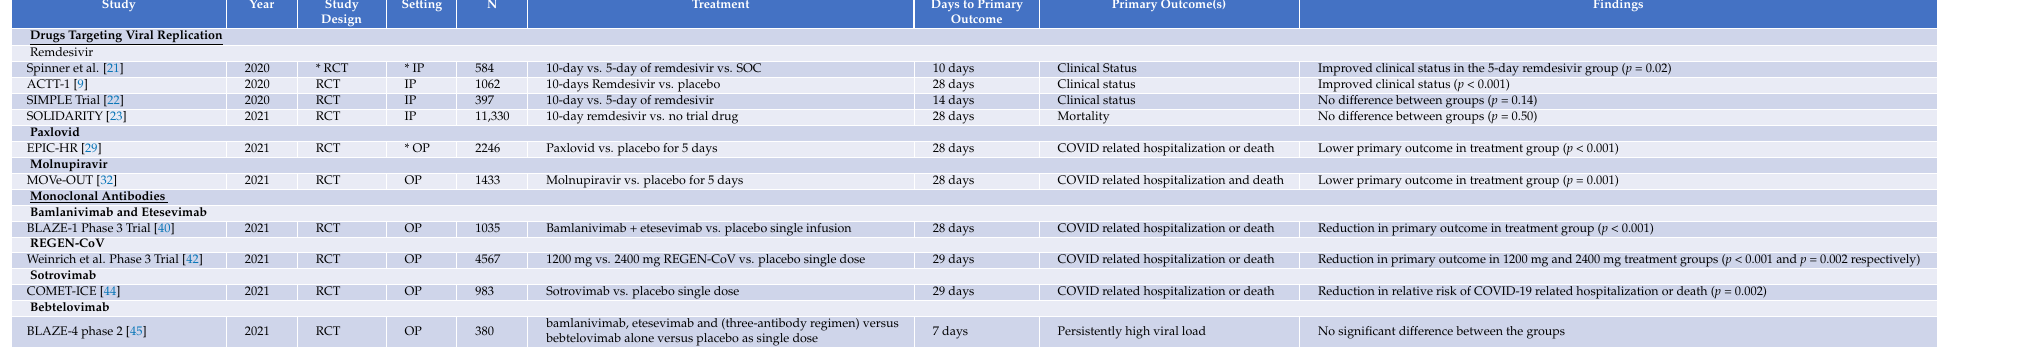
Table 1. Studies Evaluating the Effect of the Currently Used Anti-Viral Therapies Against COVID-19 in the United